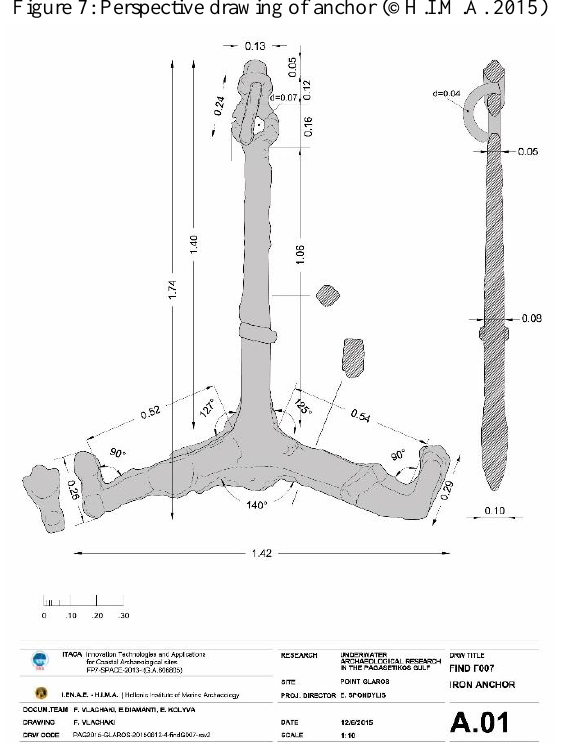
Figure 7: Perspective drawing of anchor (©H.I.M.A. 2015)